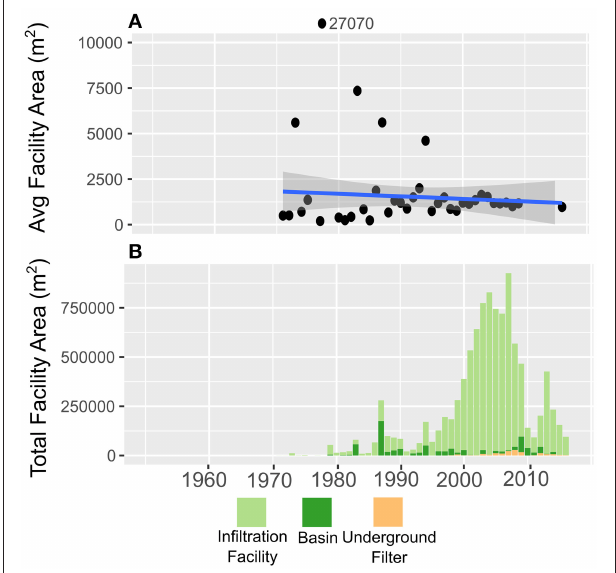
FIGURE 6 | (A) Average area of constructed SCMs for each year of record in Phoenix, with a linear model and 95% confidence intervals indicated and (B) total area of constructed SCMs for each year. Filters, porous pavement, and swales are not represented as data on area was not